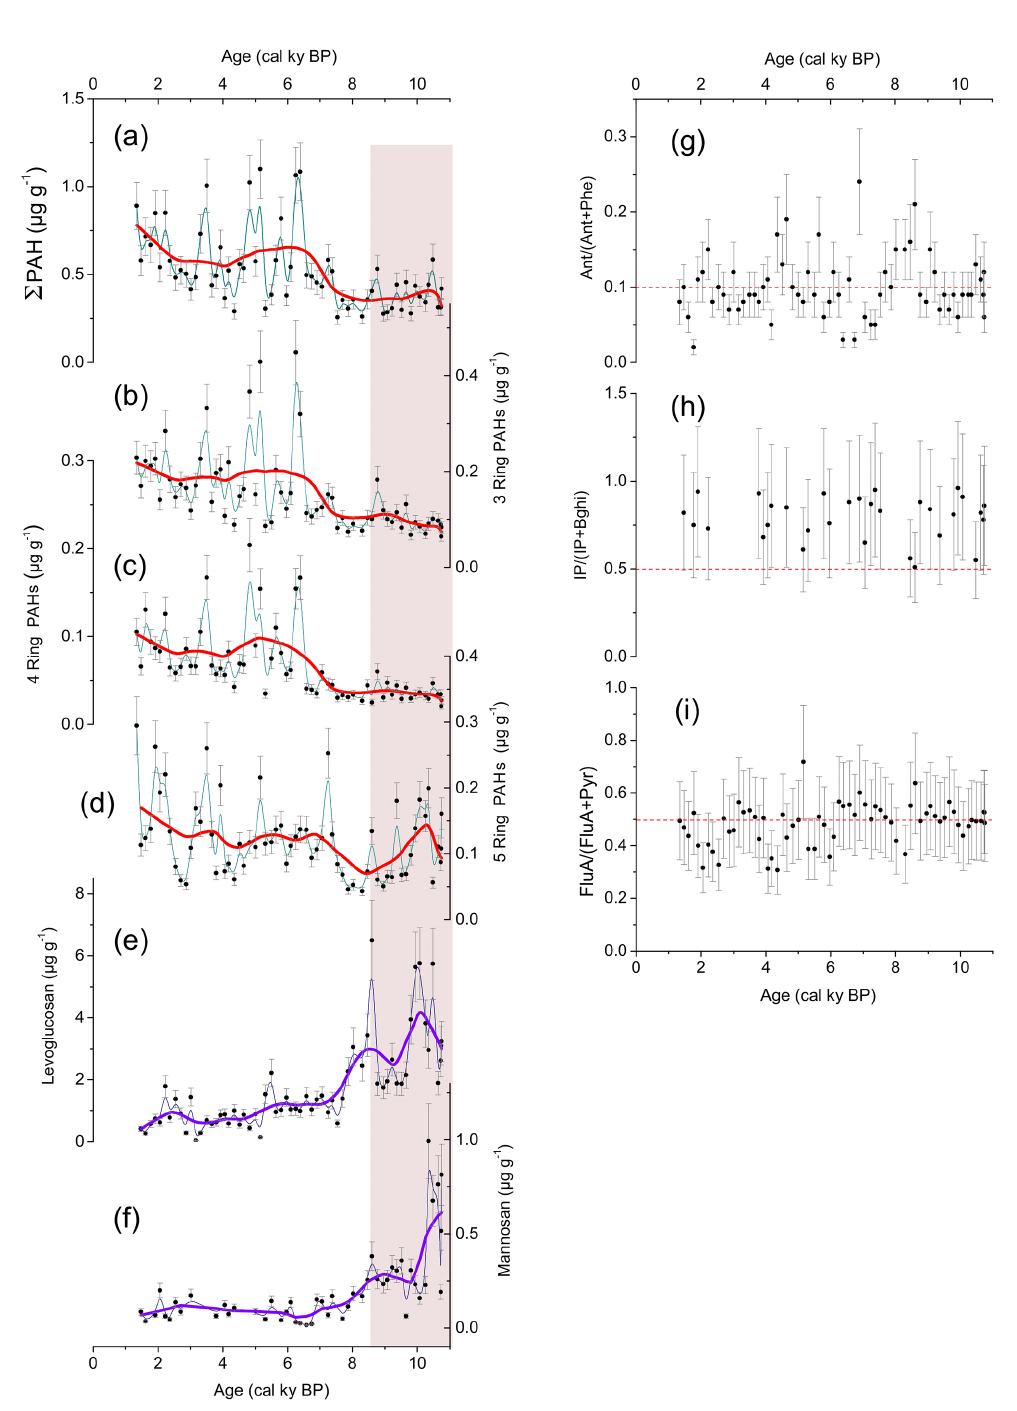
Figure 2. (a) Sum of PAH concentrations; (b) sum of 3-ring PAH concentrations (Phe, Ant, FluA); (c) sum of 4-ring PAH concentrations (Pyr, BaAnt, Chr, Ret, BbFl, Bkfl); (d) sum of 5–6 ring PAH concentrations (BaPyr, BePyr, Bghi, IP, DBahAnt). Data points (black) with absolute error range (grey), LOWESS smoothing with SPAN parameter 0.2 (red), b-spline interpolation (cyano). (e) Levoglucosan concentration; (f) Mannosan concentration. Data points (black) with absolute error range (grey), LOWESS smoothing with SPAN parameter 0.2 (purple), b- spline interpolation (dark blue). Pink bar indicates the early Holocene period where levoglucosan and 5-ring PAHs show high concentrations. (g) Ant / (Ant + Phe); (h) IP / (IP + Bghi); (i) FluA / (FluA + Pyr). Ratio values (black points) with absolute error bars (grey) and diagnostic thresholds (red dashed